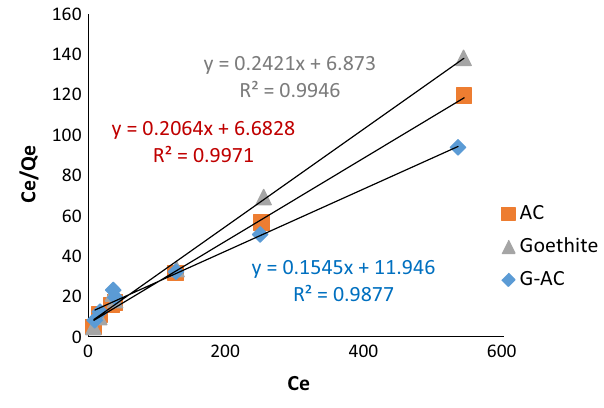
Fig. 9 Langmuir isotherm plot Cr(VI) on G, AC and GAC